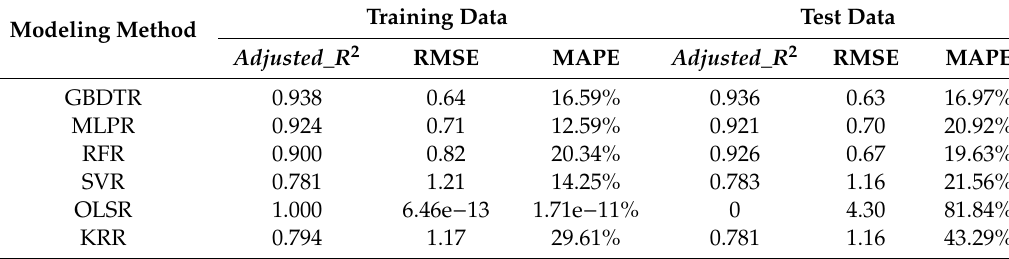
Table 4. Comparison of the retrieval results of the di ff erent regression models for the Xunsi River